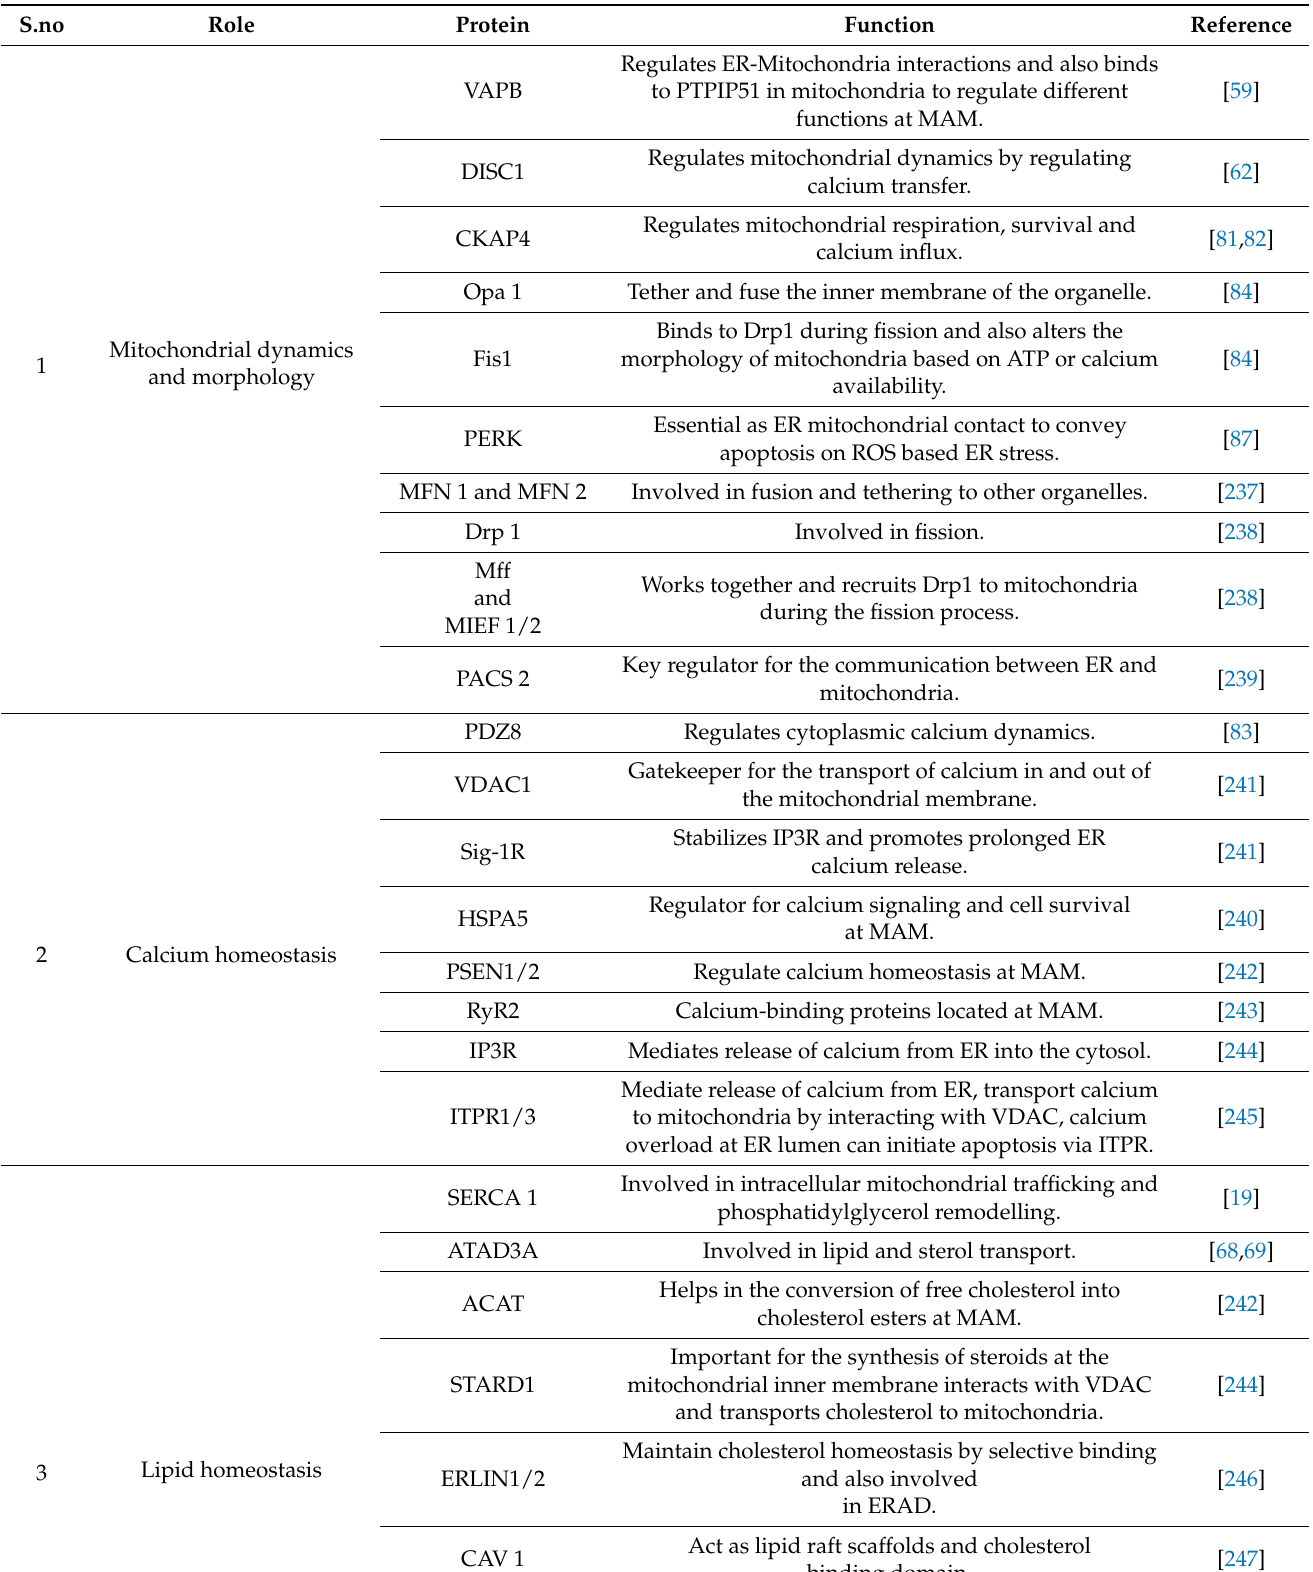
Table 2. Major mitochondria-associated ER-membrane (MAM) proteins and its functions.